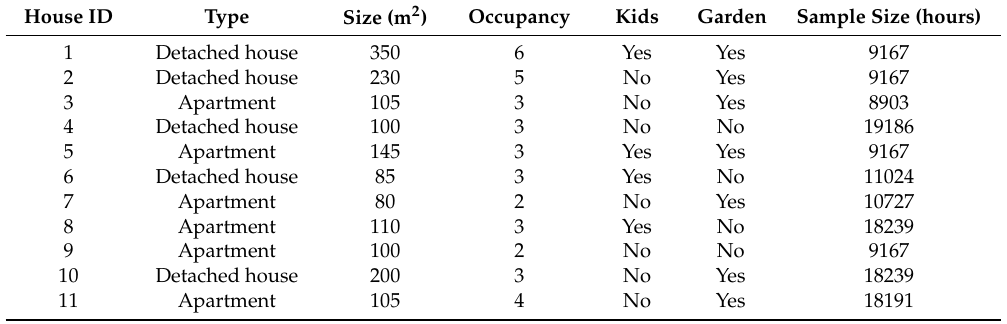
Table 1. Main characteristics of the households used in the analysis along with the size of